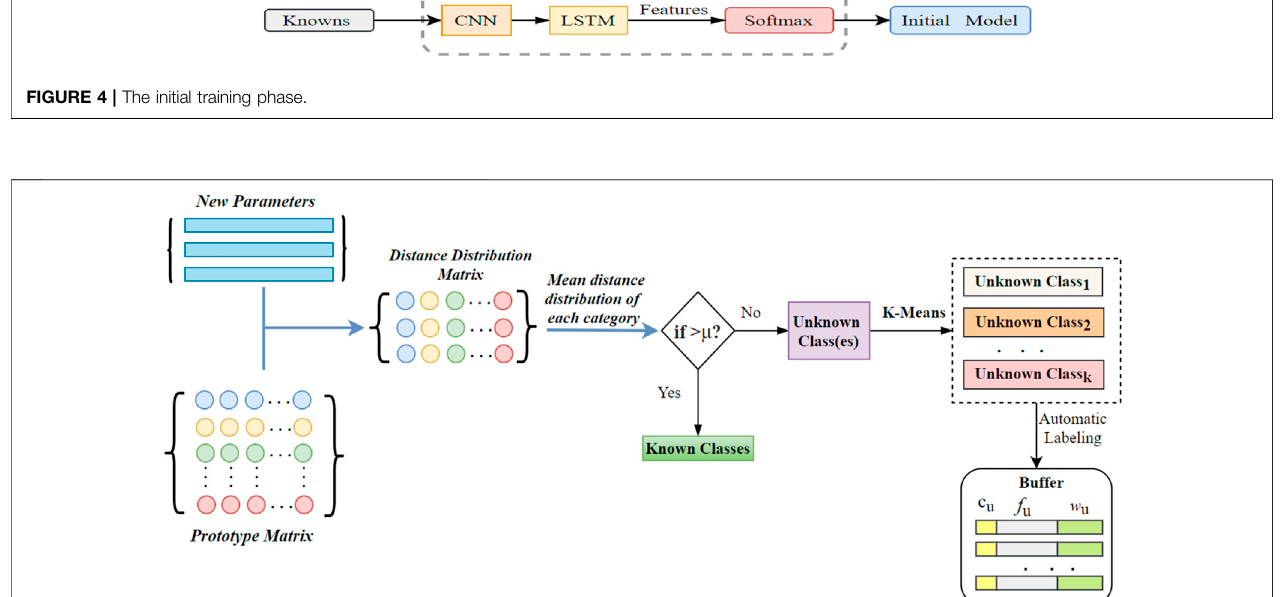
FIGURE 5 | Unknown ’ s detector